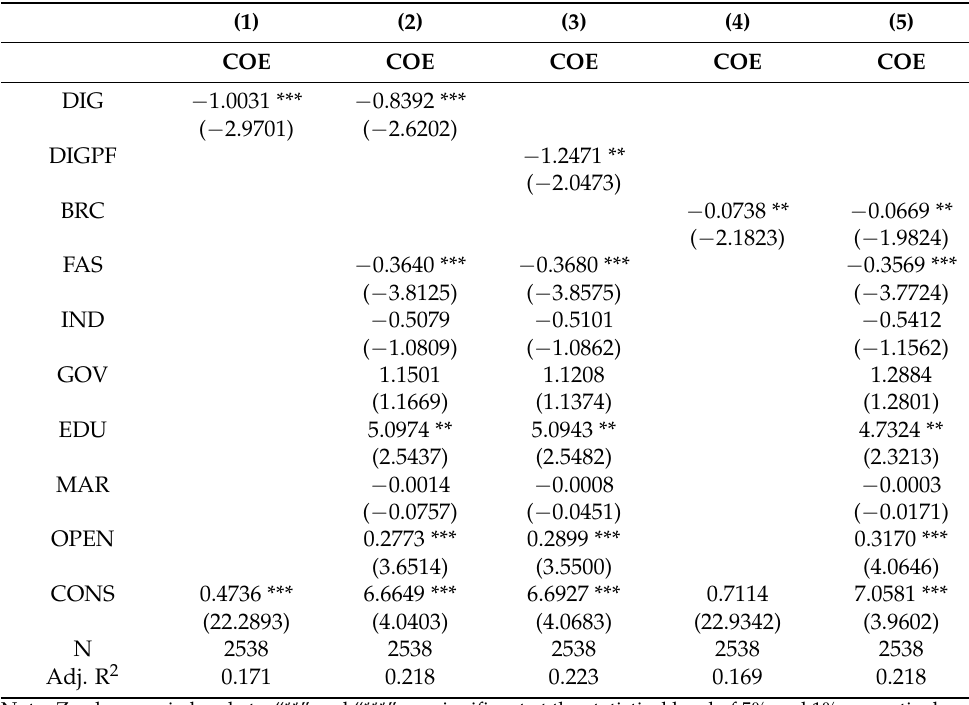
Table 3. Effect of the digital economy on carbon